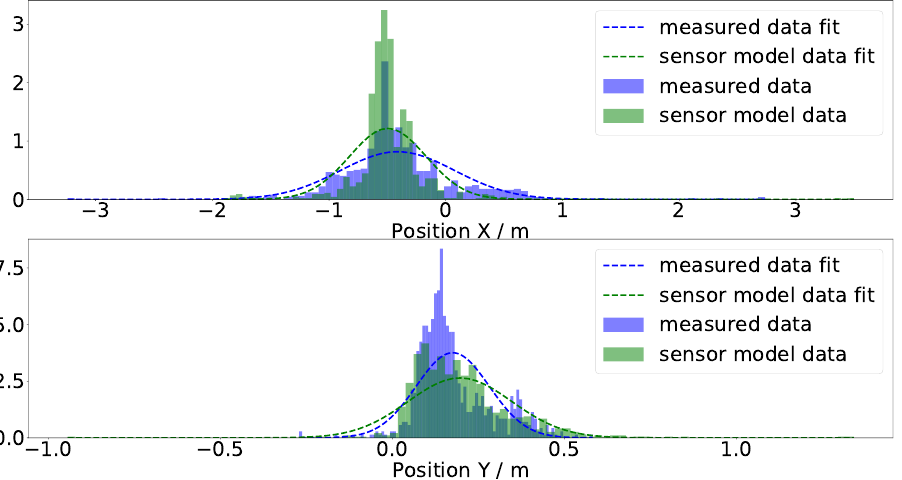
Figure 25. Histogram and Gaussian fit of the gap between the measured, respectively sim- ulated, sensor data and the ground-truth values for the inertia model extended with the distance-based